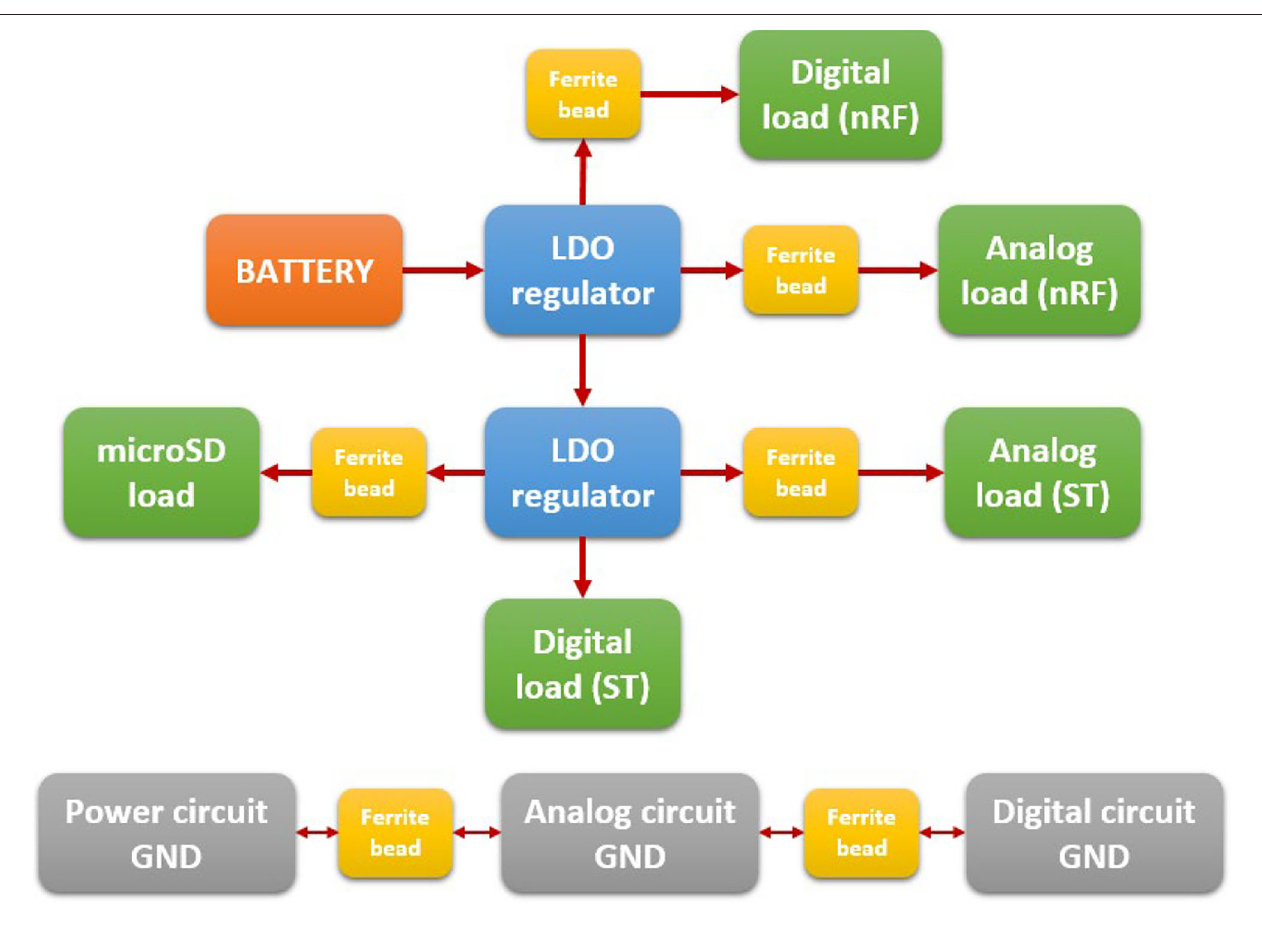
FIGURE 4 | Power system and regulator